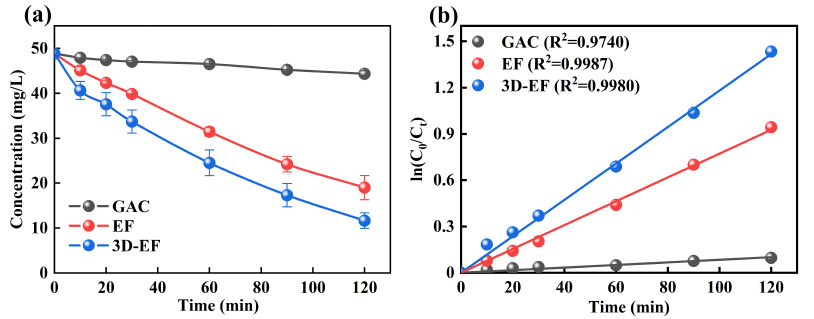
Figure 1. Decomplexation of Ni-EDTA in different systems ( a ) and kinetics fitting lines ( b ).